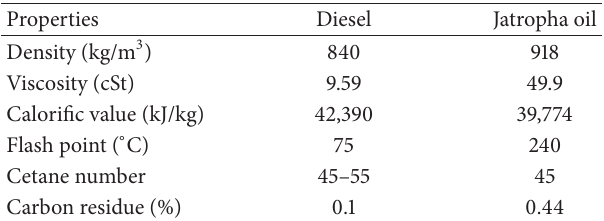
Table 1: Properties of diesel and Jatropha oil.